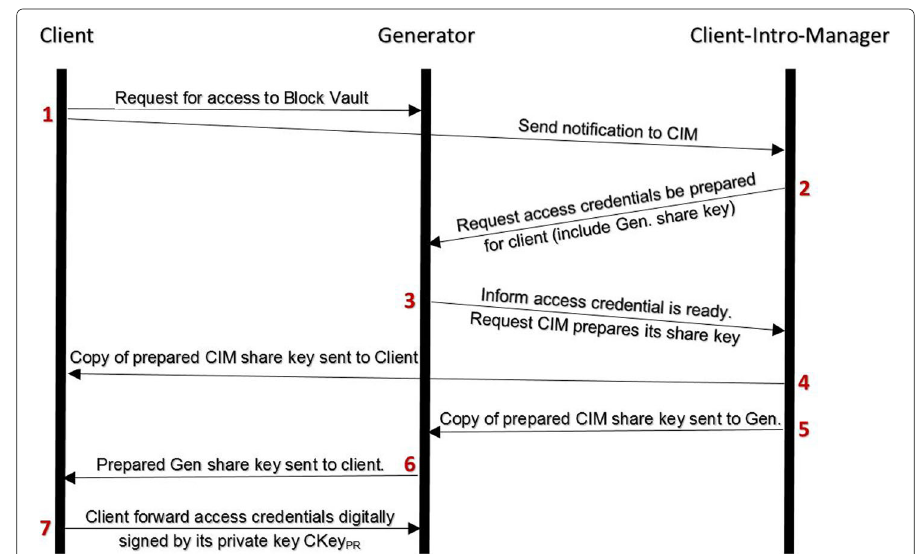
Fig. 5 Client access to vault (dual control) – sequence of